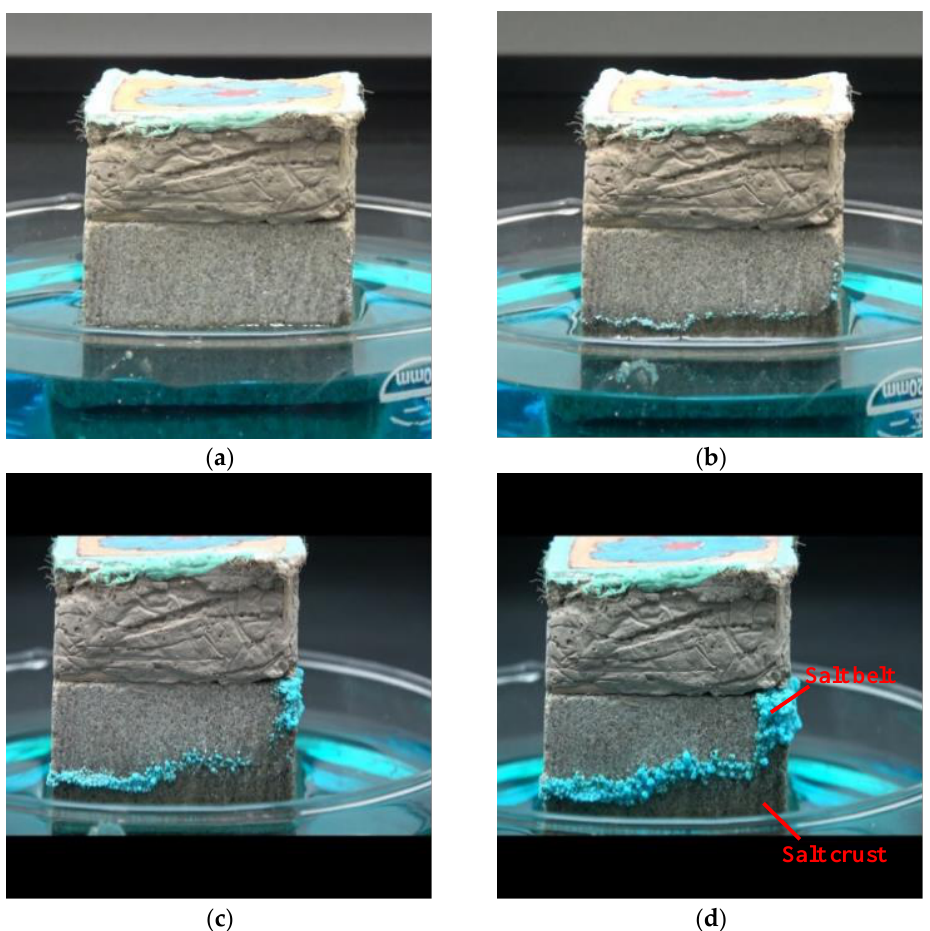
Figure 5. The transport and crystallization process of salt solution in the simulated wall painting sample ( a ) 0 h; ( b ) 7 h; ( c ) 36 h; ( d ) 72 h.